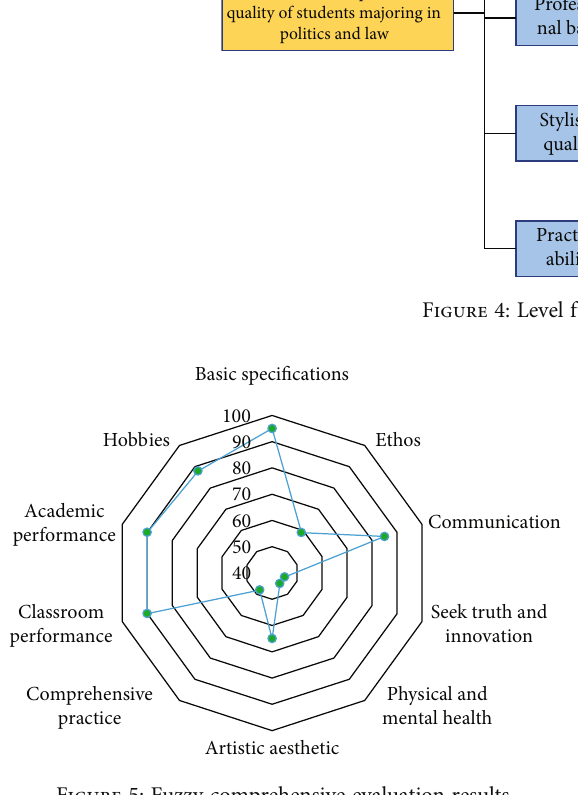
Figure 5: Fuzzy comprehensive evaluation